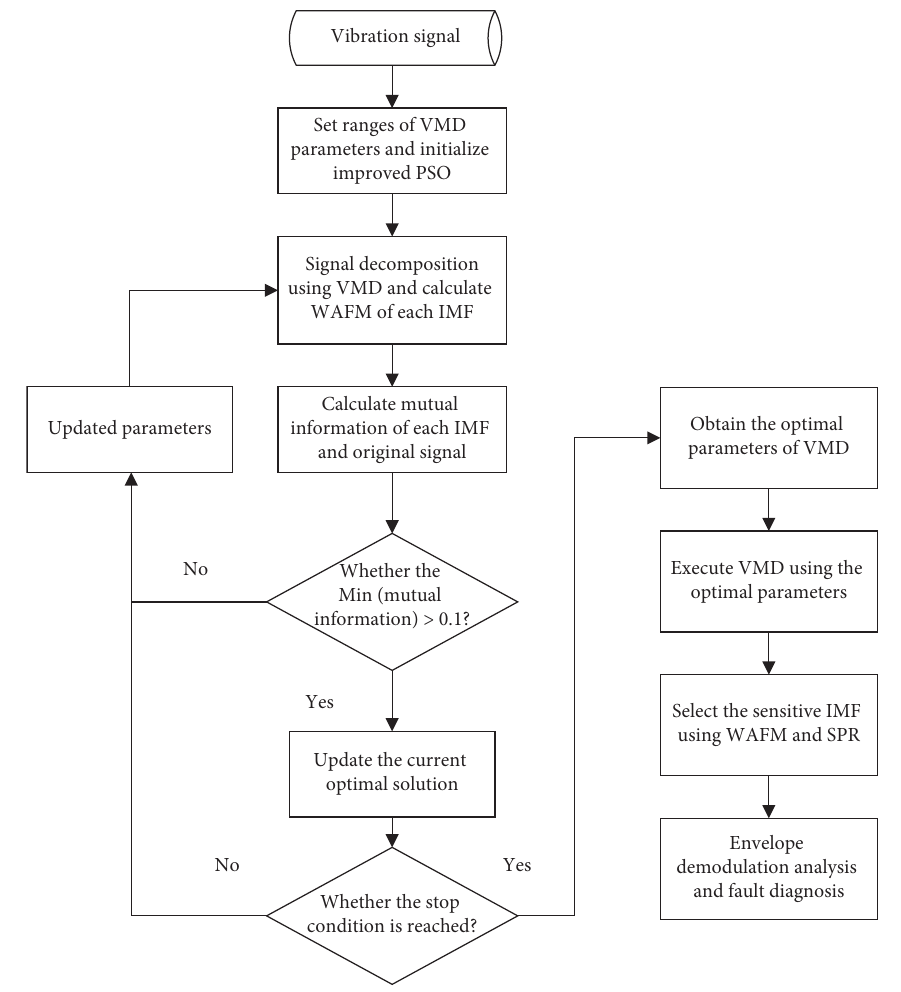
Figure 1: Flowchart of the parametric adaptive VMD